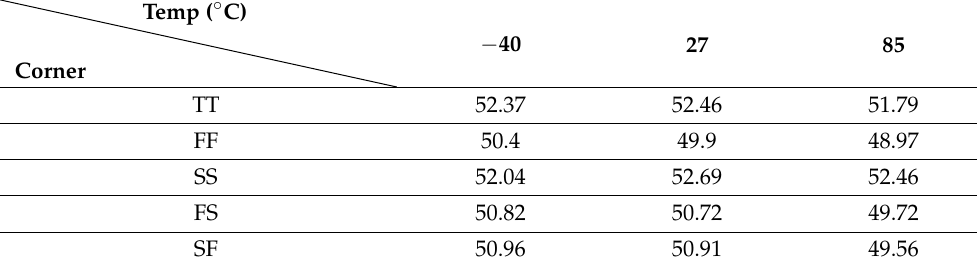
Table 5. The voltage gain corner analysis of the proposed amplifier.